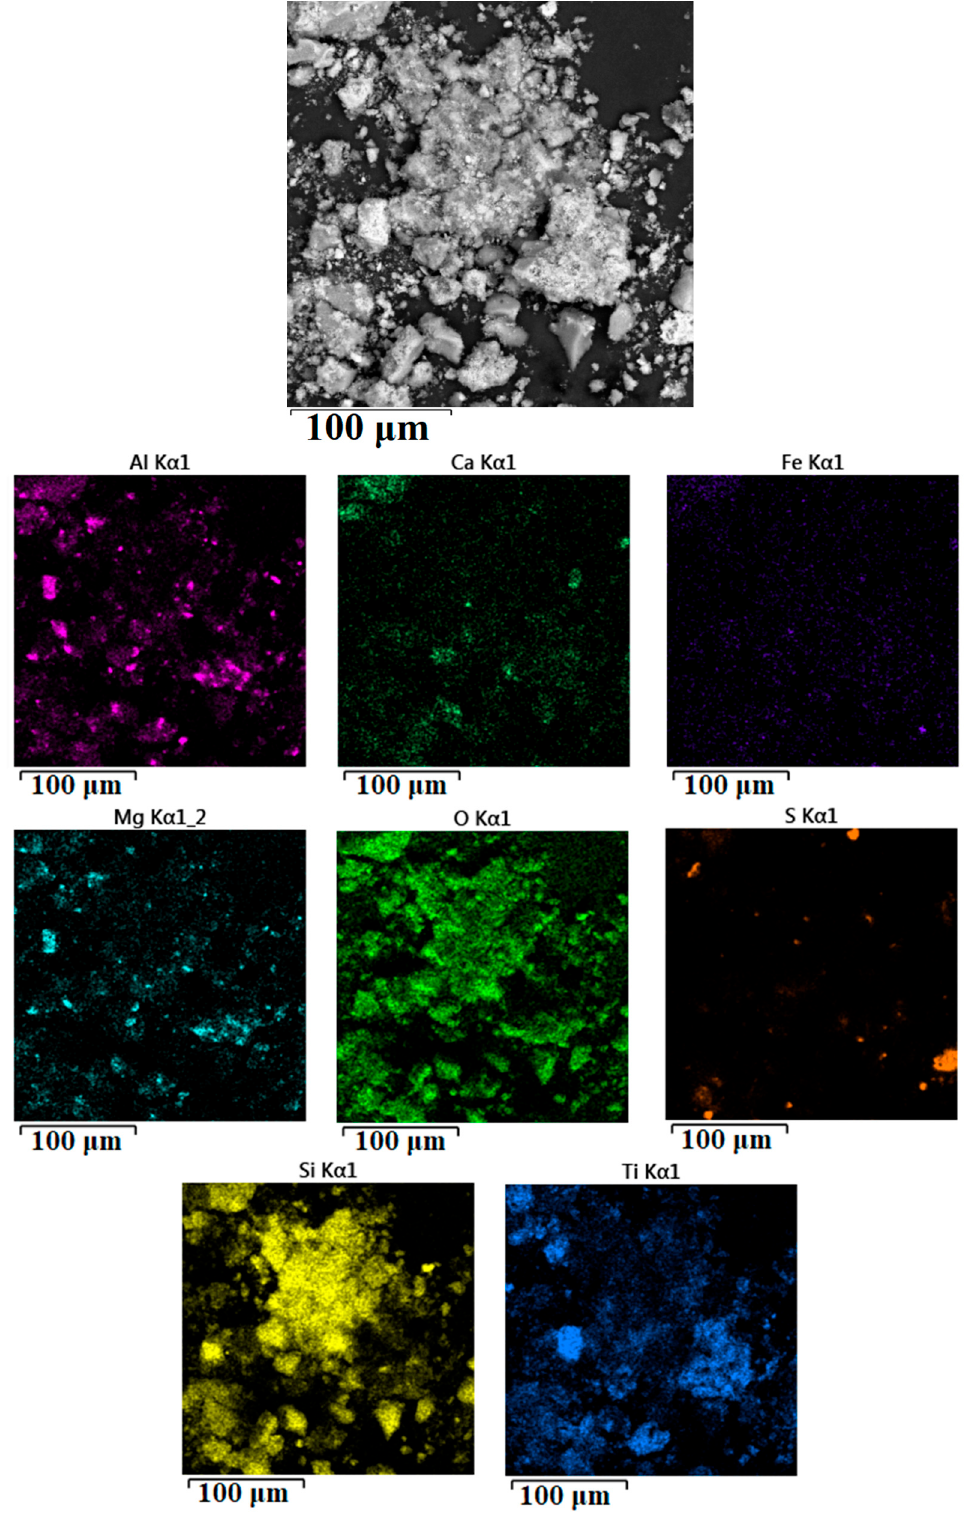
Figure 9. SEM images with the distribution of elements in the solid residue obtained by the leaching of the SSAT sample using 10% HCl at 170 °C and S:L ratio = 1:11 for 60 min.